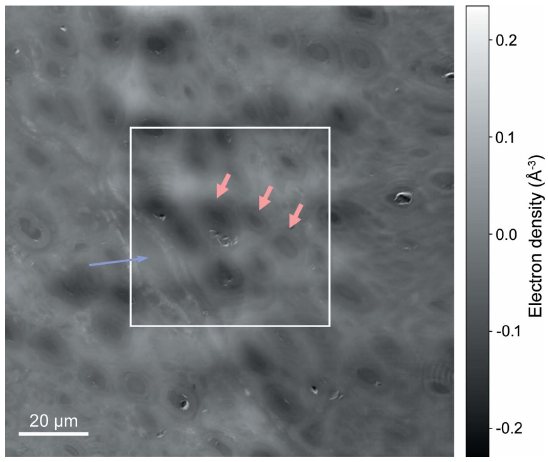
Figure 3 Quantitative result obtained from processing the images from Fig. 2. The ROI on which a nanoscale X-ray fluorescence scan was performed is highlighted by the white rectangle. A blood vessel (blue arrow) as well as myelin layers surrounding several axons (red arrows) can be identified. The intensity scale represents relative electron density variations and for convenience was converted into units of A˚ (cid:5) 3